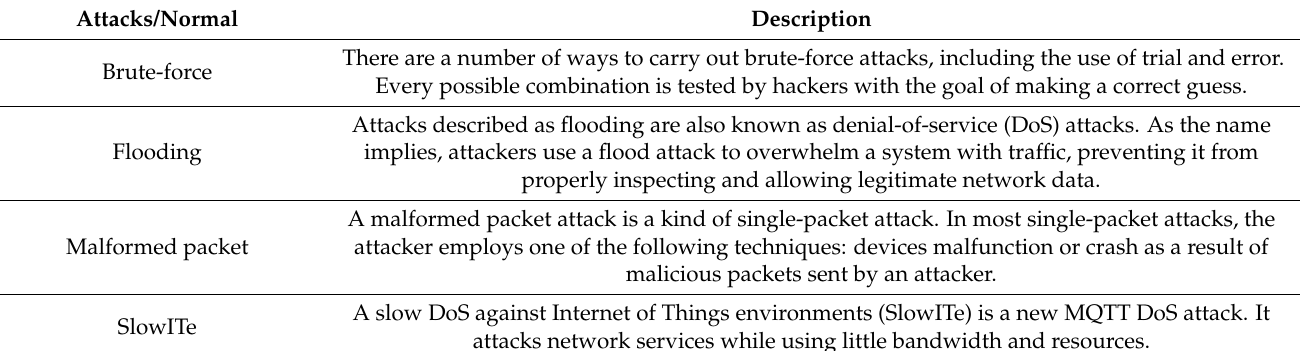
Table 1. MQTT attacks.